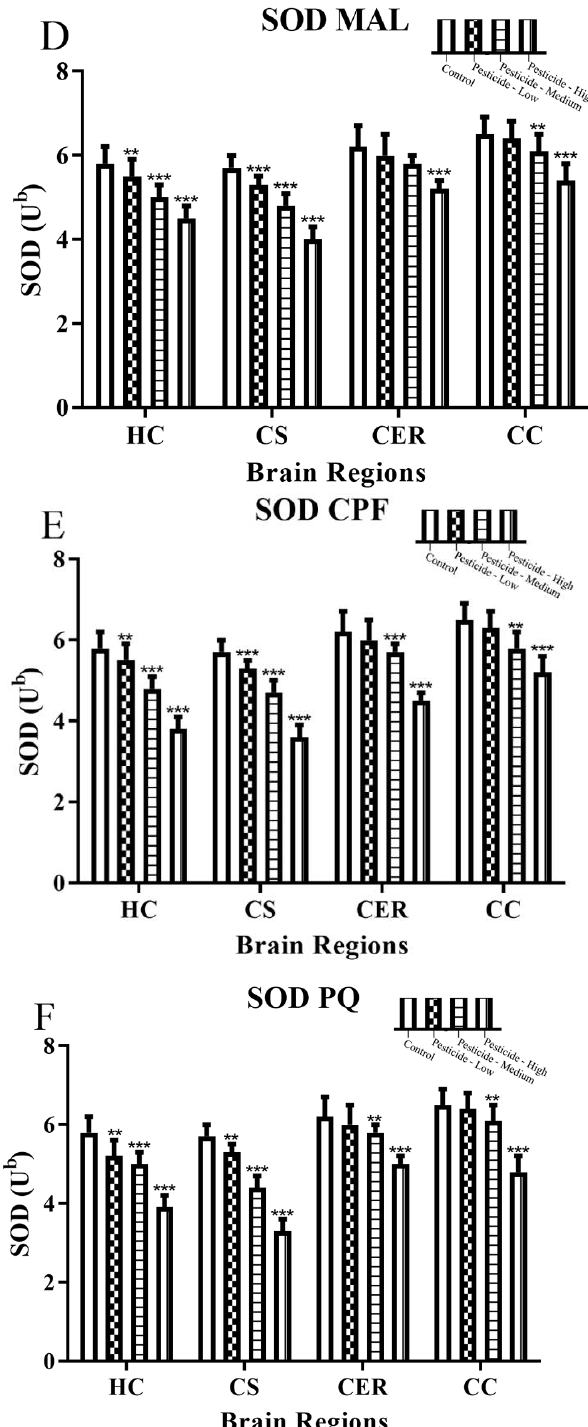
Figure 5. Pesticide-induced inhibition of catalase and superoxide dismutase activities. Rats were dosed with malathion (MAL) ( A , D ); chlorpyrifos (CPF) ( B , E ); or paraquat (PQ) ( C , F ); at low, medium, or high dosages and the activity of catalase (CAT) and superoxide dismutase (SOD) enzymes quantified as µmoles of H 2 O 2 consumed per minute per mg of protein (U b ) within the hippocampus (HC), corpus striatum (CS), cerebellum (CER), and cerebral cortex (CC). Histograms are representative of mean values with SDs, with significant changes marked with asterisks, according to ** p < 0.01, and *** p < 0.001.